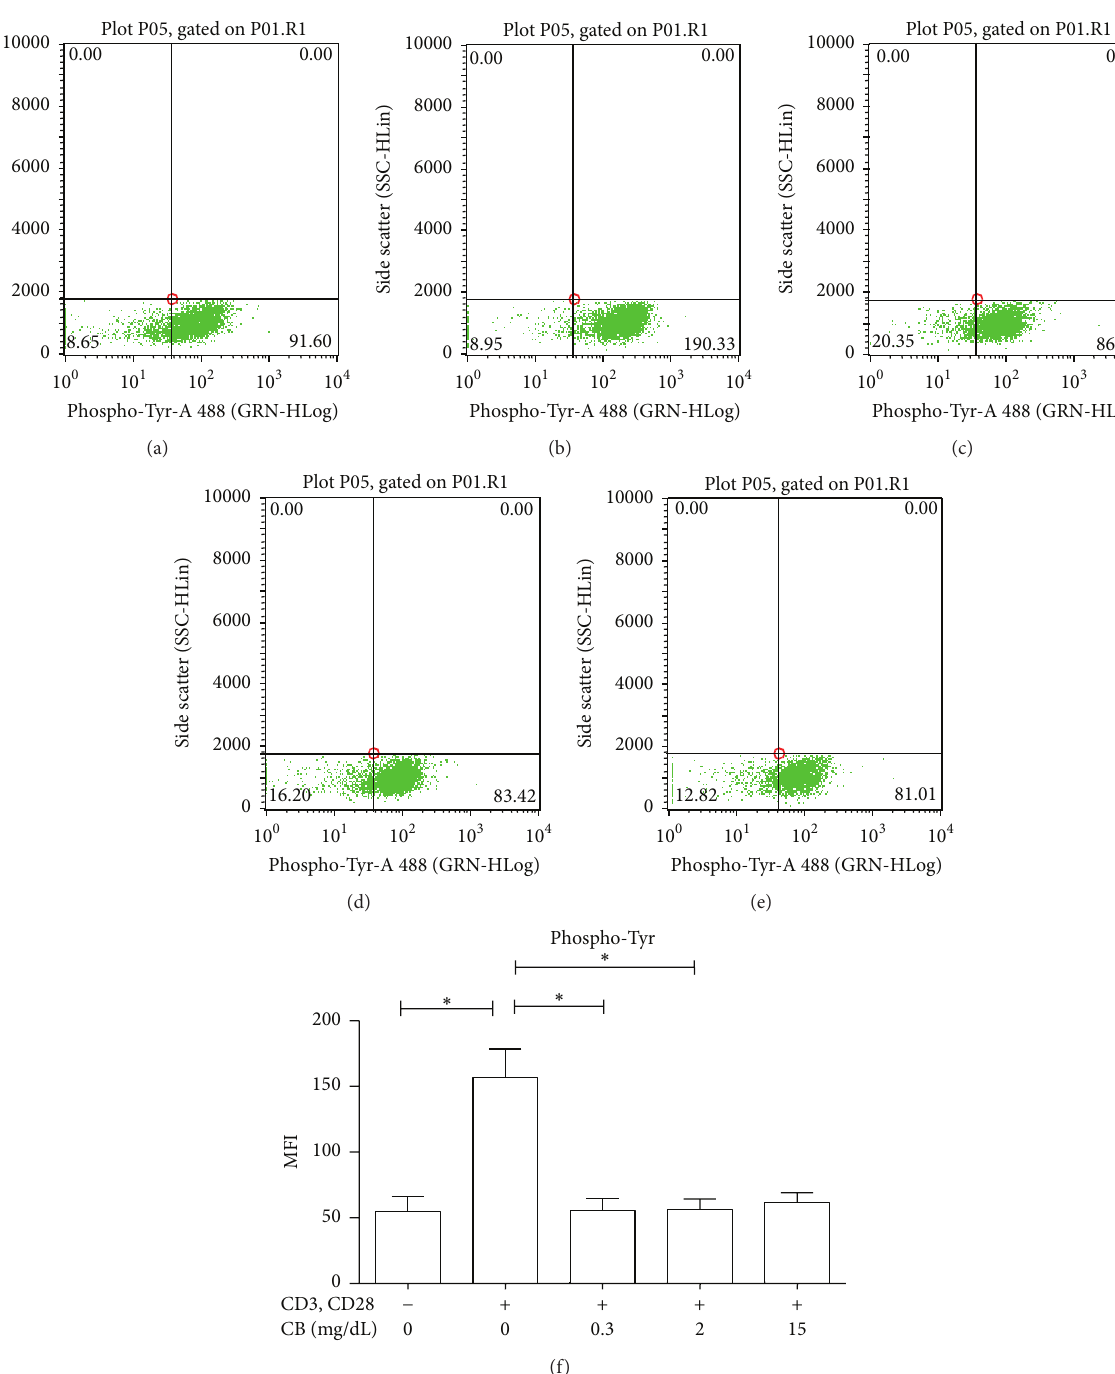
Figure 1: CB causes a decrease in the degree of tyrosine phosphorylation in human CD4+ TLs in vitro . Purified CD4+ TLs from pediatric healthy donors were incubated at 37 ∘ C, 5% CO 2 , 30 min, under different conditions: (a) TLs without stimulus. (b) TLs with anti-CD3 and anti- CD28. (c) TLs with anti-CD3, anti-CD28, and 0.3 mg/dL CB. (d) TLs with anti-CD3, anti-CD28, and 2 mg/dL CB. (e) TLs with anti-CD3, anti- CD28, and 15mg/dL CB. Cells were subsequently recovered and stained with an anti-pTyr mAb and then analyzed by using flow cytometry. Representative dot plots are shown (a–e). (f) The medians and standard deviations of three repetitions are presented. Nonparametric Kruskal- Wallis for comparison between groups was used to calculate statistical significance. 𝑃 < 0.05 was considered statically significant. ∗ 𝑃 < 0.05